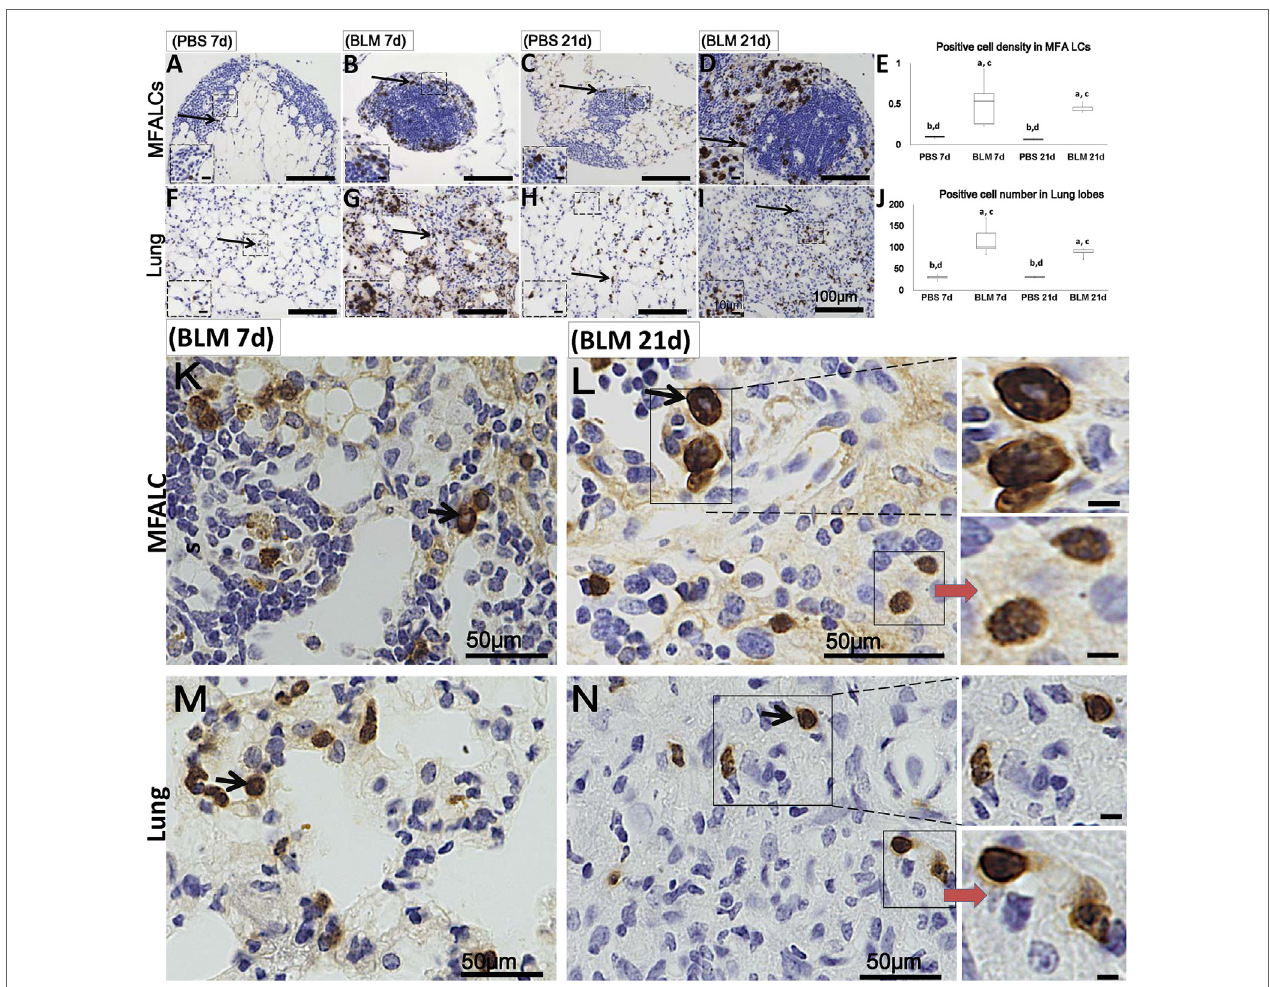
FigUre 4 | Granulocyte cell populations within mediastinal fat-associated lymphoid clusters (LCs) (MFALCs) and lung infiltrates in mouse model of bleomycin (BLM)-induced pneumonitis. Immunohistochemical images (low-power) show Gr-1 + cells in MFALCs (a–D) and lung tissues (F–i) of PBS group at 7 days, BLM group at 7 days, PBS group at 21 days, and BLM group at 21 days, respectively. (e) Gr-1 + cell density in MFALCs. (J) Average number of Gr-1 + cells in lung tissues. The letters a, b, c, and d: significant differences between PBS group at 7 days (a), BLM group at 7 days (b), PBS group at 21 days (c), and BLM group at 21 days (d), analyzed by the Kruskal–Wallis test, followed by the Scheffé’s method ( P < 0.05); n = 5 in each experimental group. Values = mean ± SE. Immunohistochemical images (high power) show Gr-1 + cell in MFALCs (K,l) and lung tissues (M,n) of BLM groups at 7 and 21 days post-instillation. Some cells showed lobulated nucleus with complete or incomplete rings, others showed smooth non-lobulated ring shaped nucleus with central basophilic cytoplasm